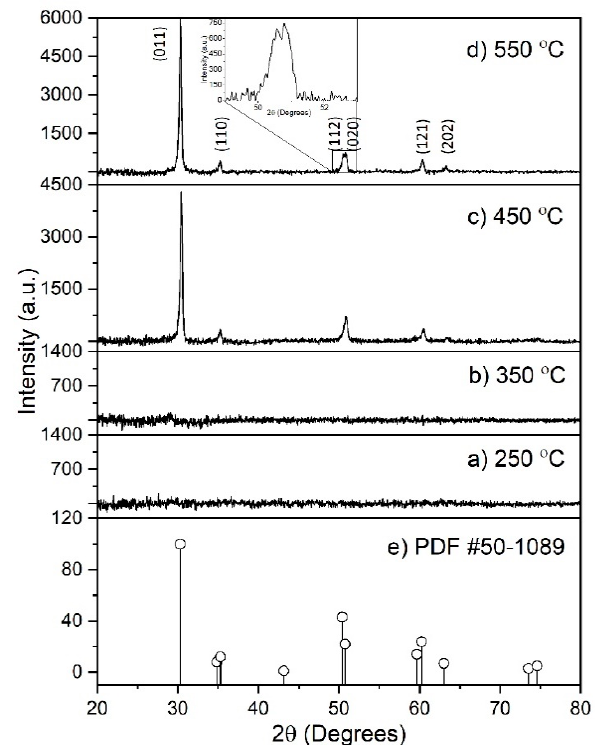
Figure 1. X-ray di ff raction (XRD) patterns of Zirconium oxide (ZrO 2 ) thin films annealed at di ff erent Figure 1. X-ray diffraction (XRD) patterns of Zirconium oxide (ZrO 2 ) thin films annealed at different temperatures ( a ) 250 ◦ C, ( b ) 350 ◦ C, ( c ) 450 ◦ C, and ( d ) 550 ◦ C. ( e ) At the bottom, the standard JCPDS temperatures ( a ) 250 °C, ( b ) 350 °C, ( c ) 450 °C, and ( d ) 550 °C. ( e ) At the bottom, the standard JCPDS card data for tetragonal ZrO 2 are provided as references (PDF card data for tetragonal ZrO 2 are provided as references (PDF #50-1089).